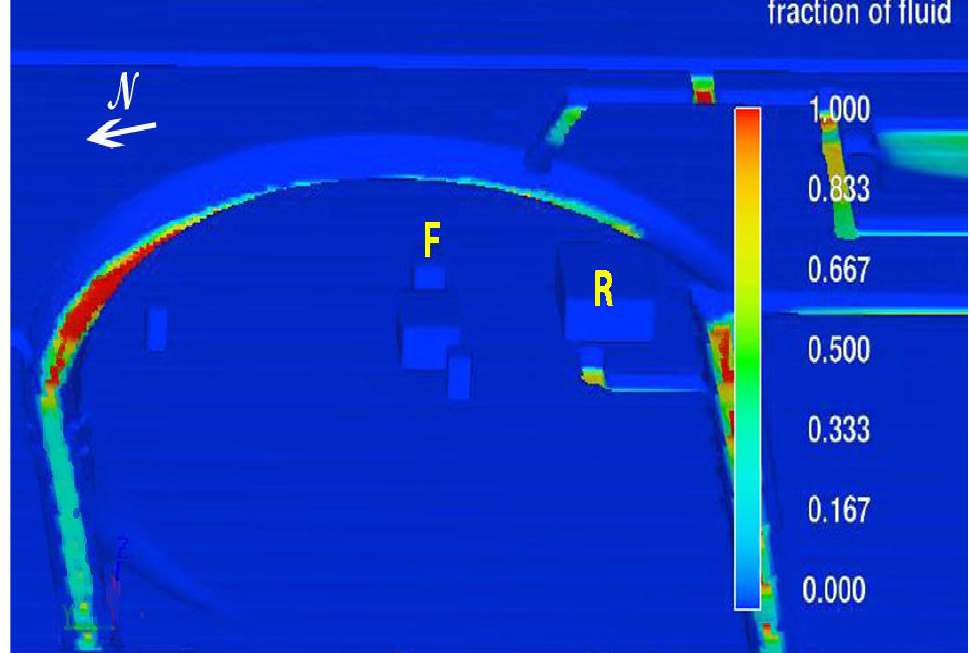
Figure 54. Late dry season fluid fraction results; from [2], p. 181.